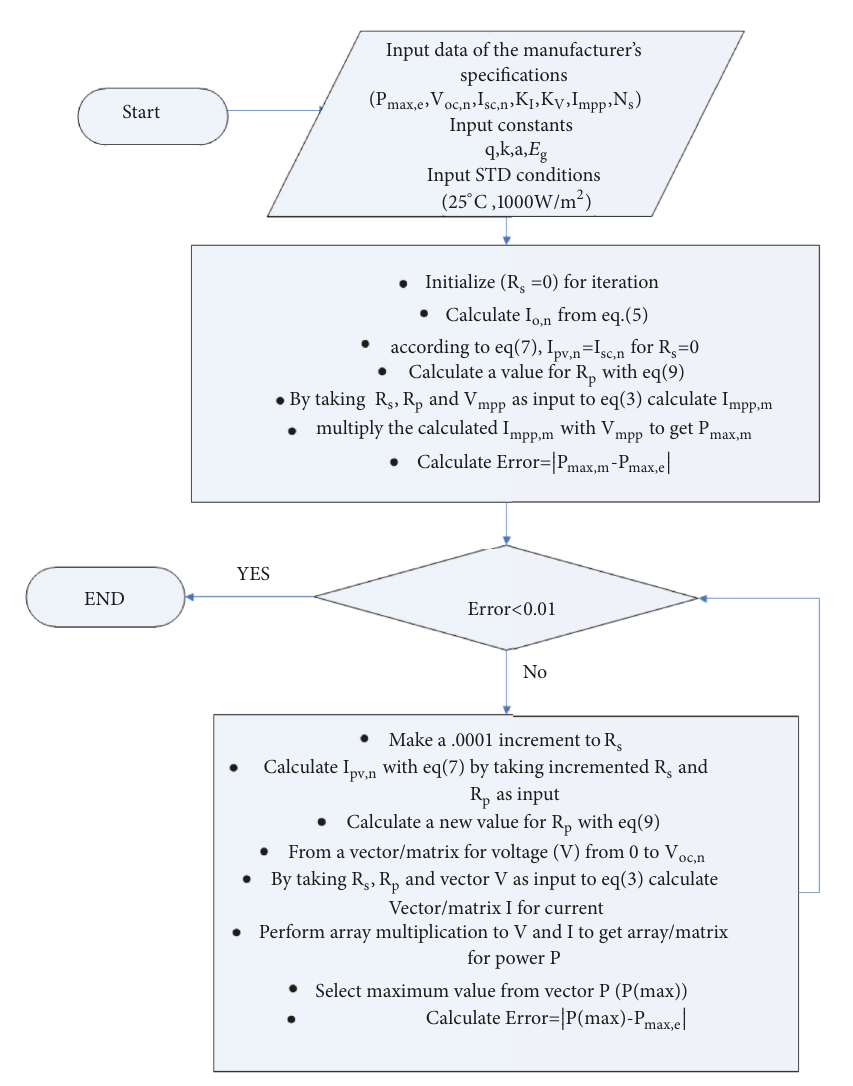
Figure 4: Algorithm of computer program used to model a PV